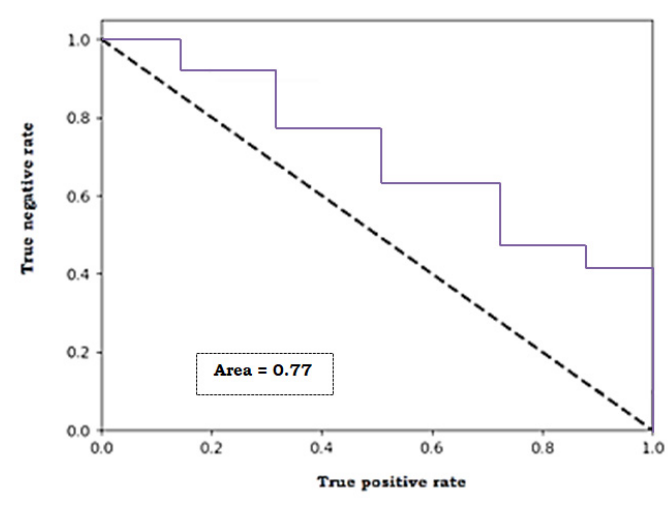
Figure 6. Receiver operating characteristic curve for multilayer perceptron.